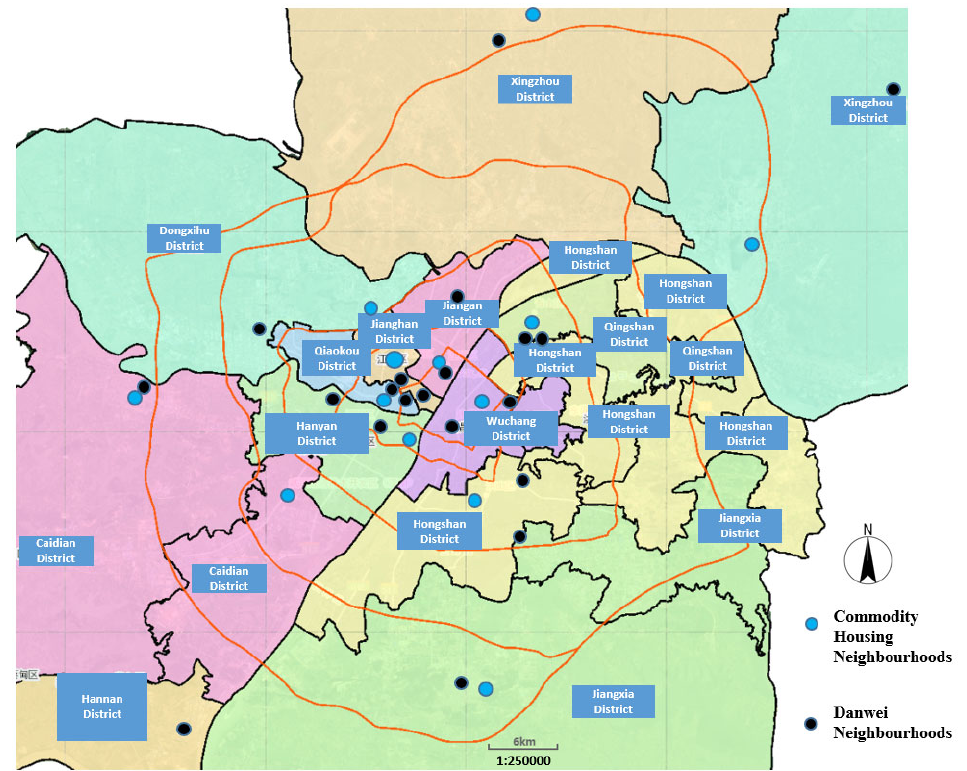
Figure 4. The location of all the 34 selected neighbourhoods in Wuhan.